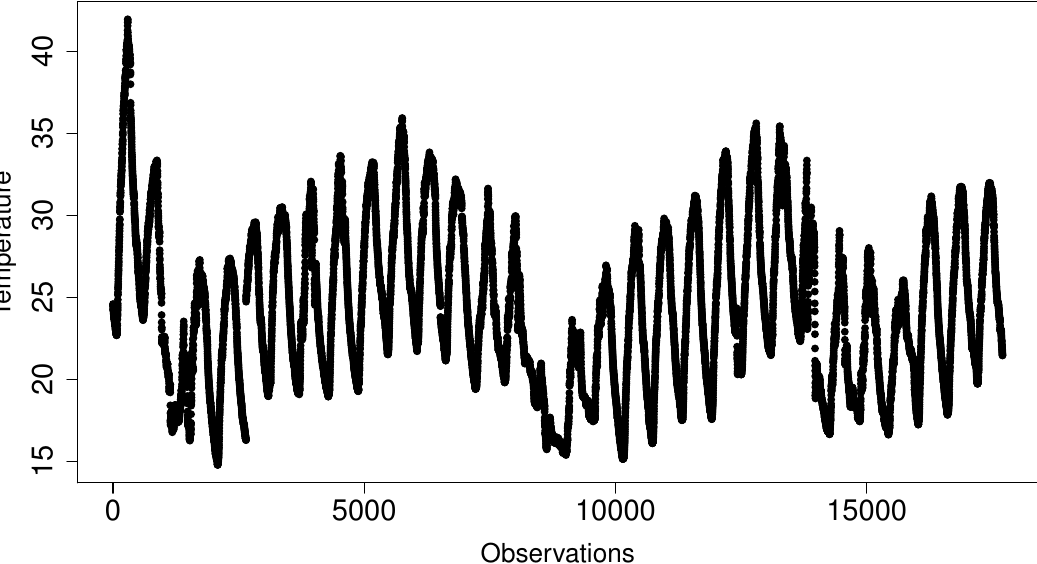
Figure 5. Observations taken by Sensor-1850, Sofia Air Quality Dataset